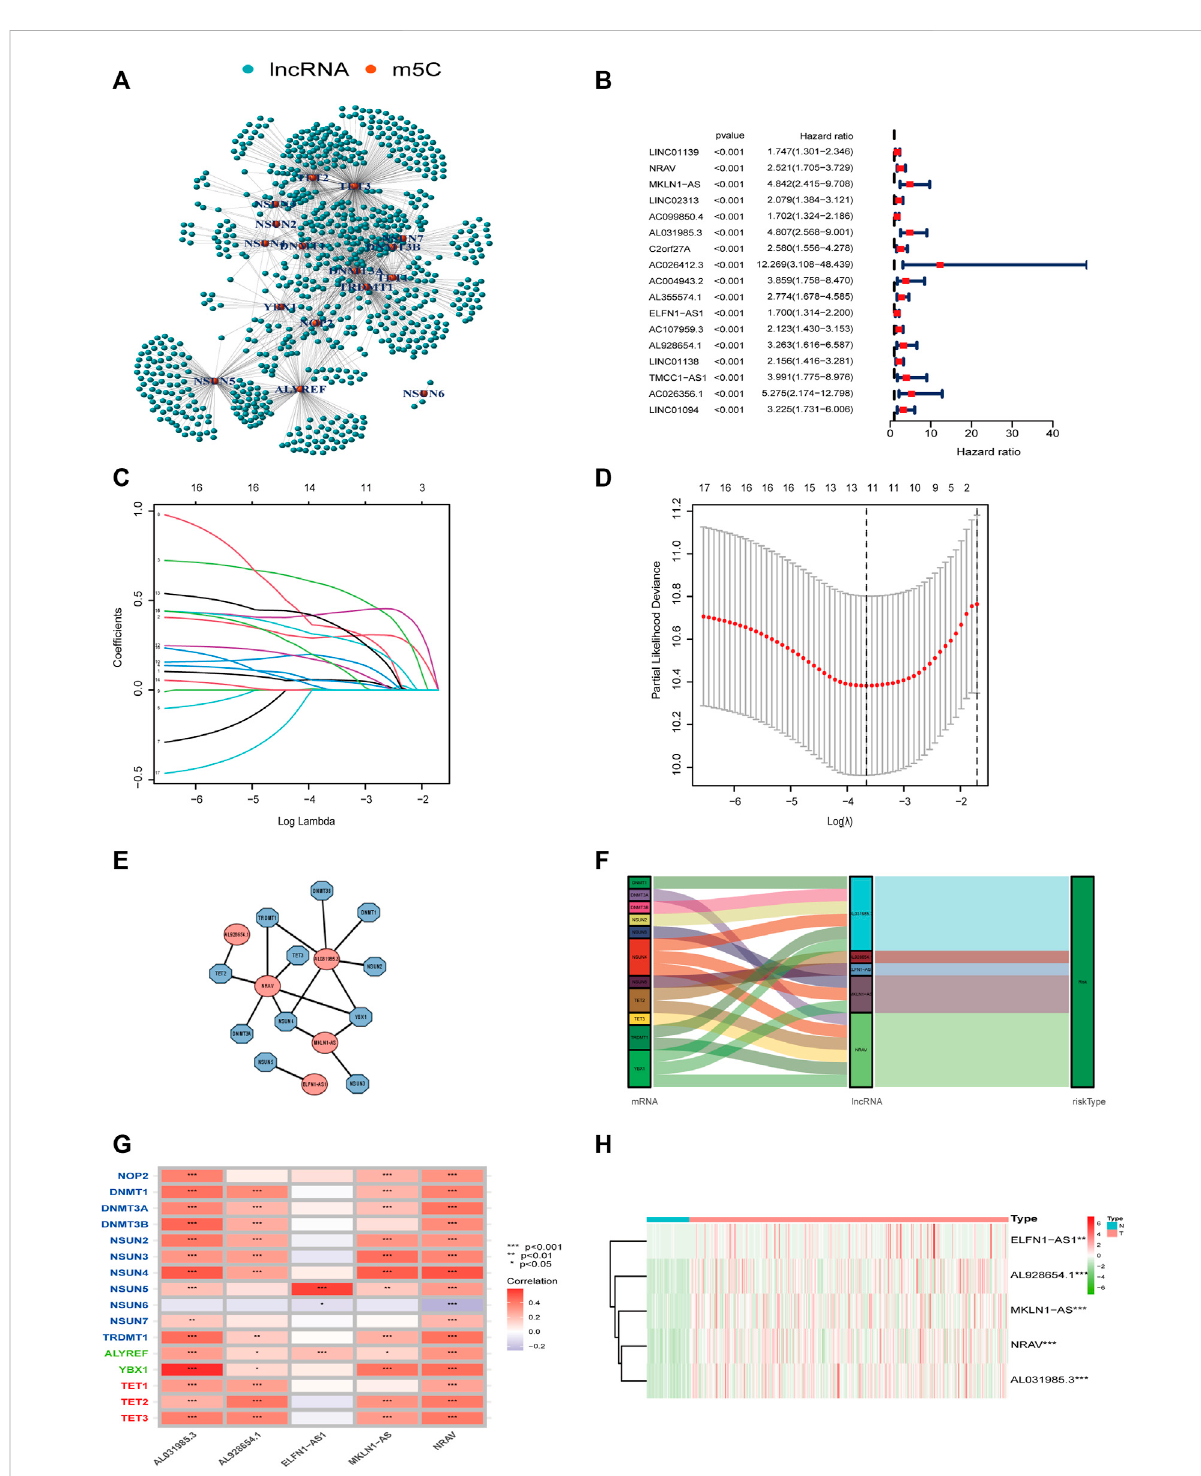
FIGURE 3 Construction of the m5C-lncRNA risk model. (A) The co-expression network of m5C regulators and their related lncRNAs. (B) Forest plot showing the hazard ratio of 17 lncRNAs with prognostic value using univariate Cox regression analysis. (C,D) LASSO regression is performed, and cross-validation for optimal parameter. (E) Co-expression network of the fi ve m5C-related lncRNAs and m5C regulators. (F) Sankey diagram showing the relationship between m5C regulators and m5C-related lncRNAs. (G) The correlations between 16 m5C regulators and fi ve m5C- related lncRNAs. (H) Heatmap of the differential expression of fi ve lncRNAs in tumor-and normal